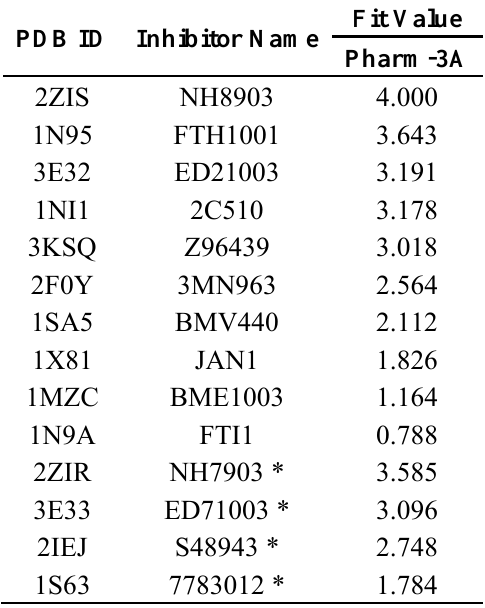
Table 2. Best-fit values of the training and test set compounds based on common feature pharmacophore technique.